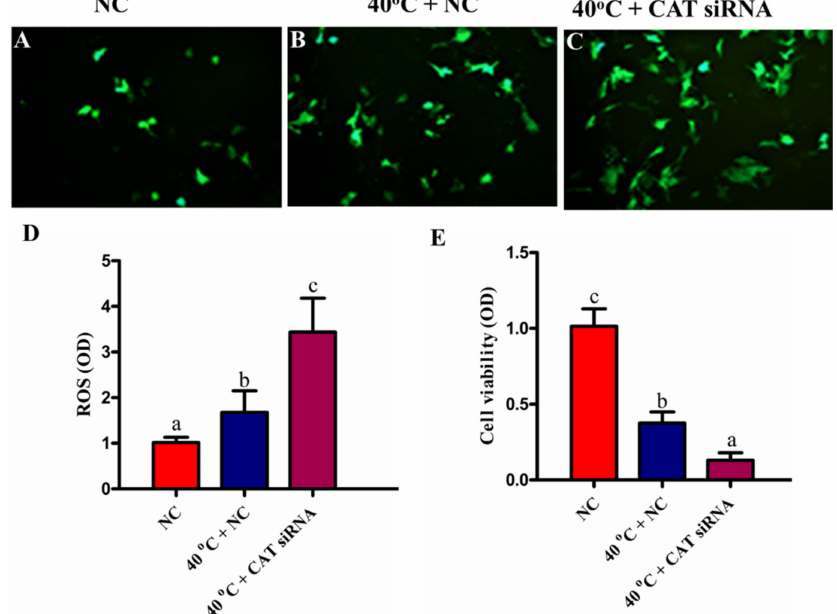
Figure 4. CAT regulates intracellular accumulation of ROS and viability of GCs under heat stress (HS). Intracellular ROS abundance measured through DCF fluorescence; NC ( A ) and HS (40 ◦ C + NC and 40 ◦ C + CAT si RNA) ( B , C , respectively). Quantitative analysis of relative fluorescence emission ( D ). The cells transfected with CAT si RNA under HS were subjected to MMT cell viability assay ( E ). Values are expressed as mean ± SEM of n = 3. Superscripts (a, b, c) represent a significant ( p < 0.05) di ff